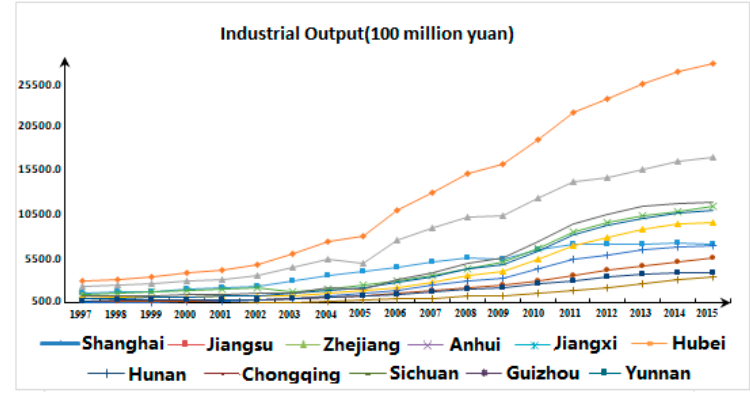
Figure 3. Industrial Output Diagram of the Yangtze River Economic Belt.